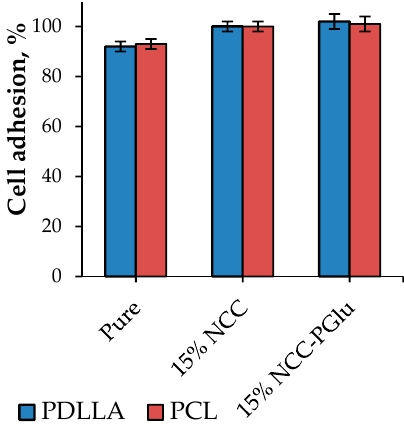
Figure 7. MTT test: Comparison of mesenchymal stem cells (MSC) cell adhesion on the surface of different materials. (Conditions: 24 h of cultivation, 5 × 10 3 cells per well. Data presented as average ± SD (n = 4))